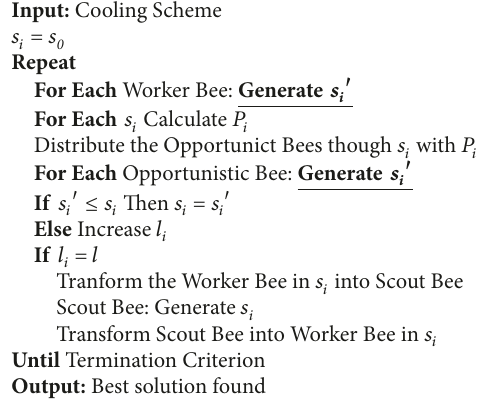
Algorithm 3: Discrete Artificial Bee